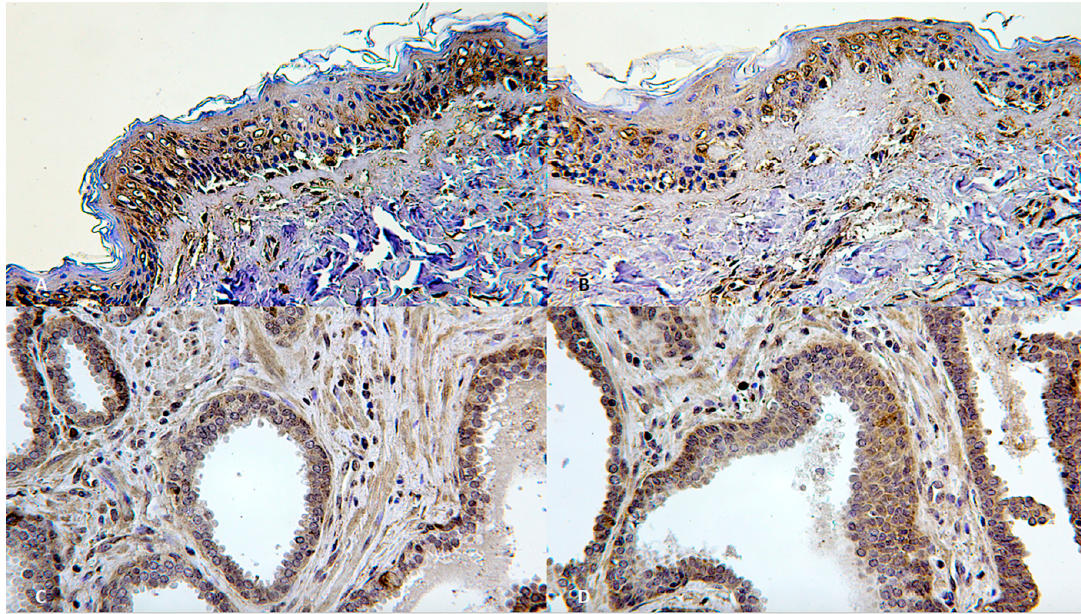
Figure 5. ( A , B ) Positive control: skin samples with normal intracytoplasmic representation of anti-FLIP (×60). ( C , D ) Increase anti-FLIP intracytoplasmic representation in resistant prostate cancer (×60 and ×200, respectively).